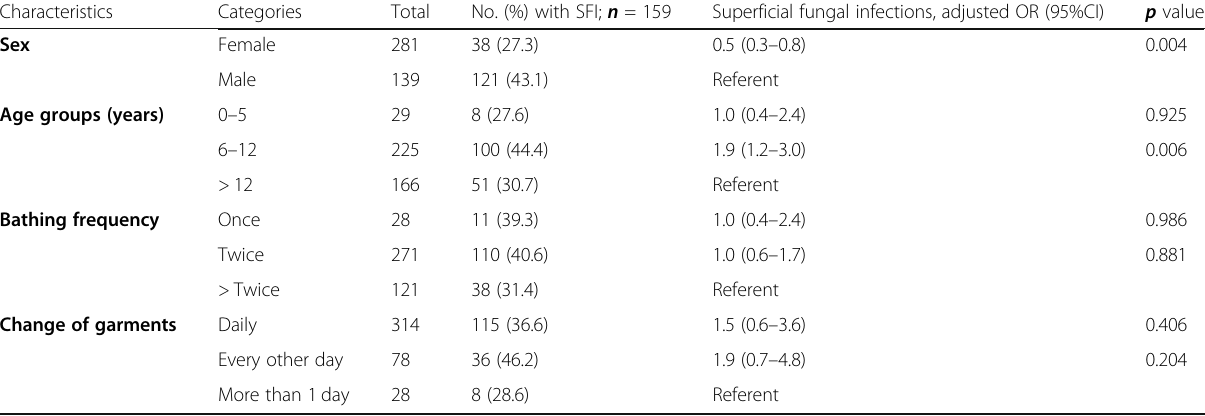
Table 6 Multivariate analysis of commonly encountered dermatological conditions among children living in orphanage centres, Dar es